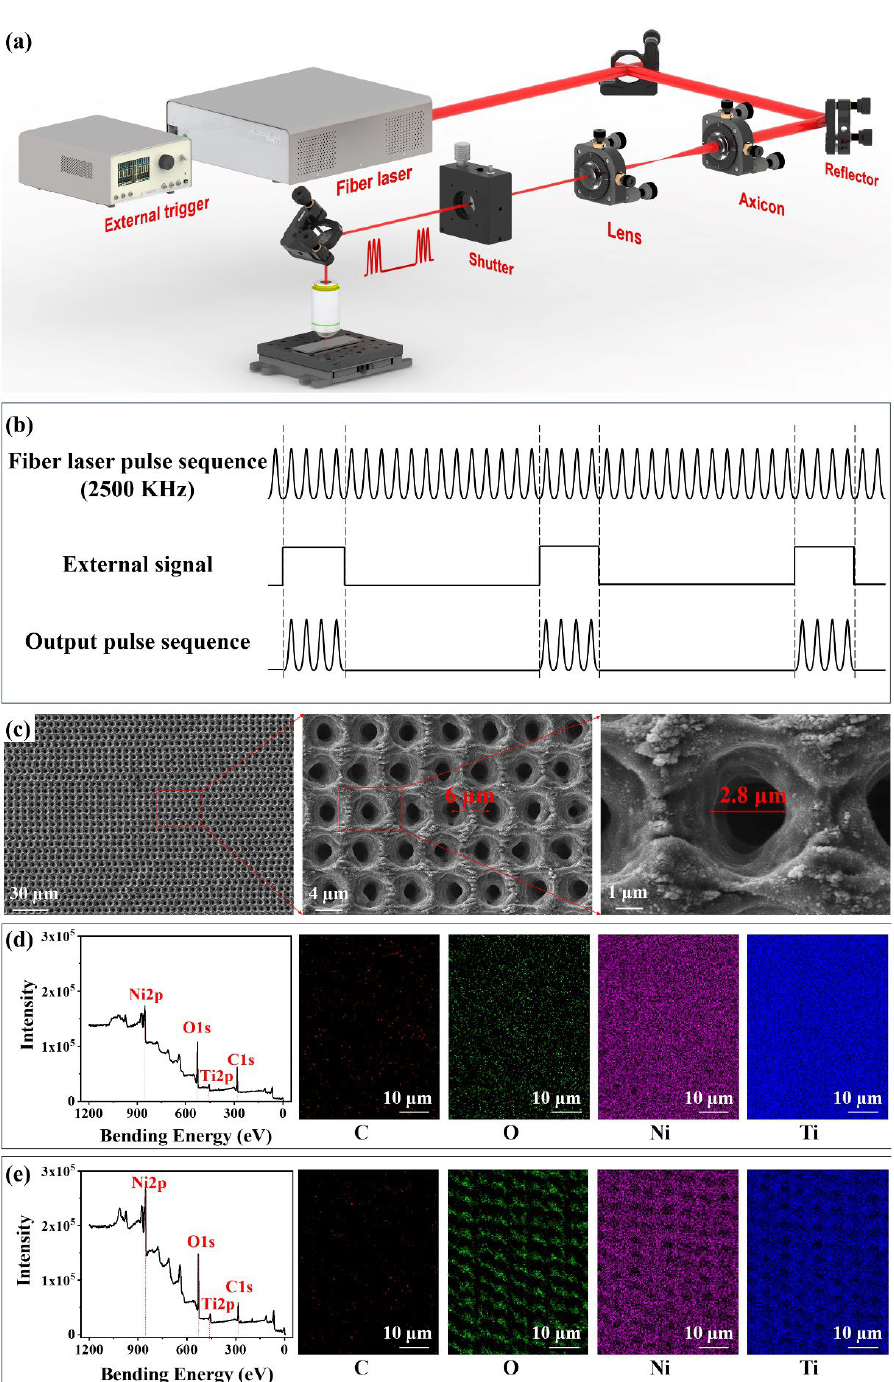
Figure 1. Schematic diagram and morphological characteristics of microporous processing on a metallic surface. ( a ) Optical path diagram of wavelength-scale micropores on metal. ( b ) Schematic diagram of the principle of controlling the output pulse train by external trigger. ( c ) Surface morphologies of microporous NiTi alloy. ( d , e ) Elements distribution and intensity of NiTi alloy ( d ) before and ( e ) after laser ablation.